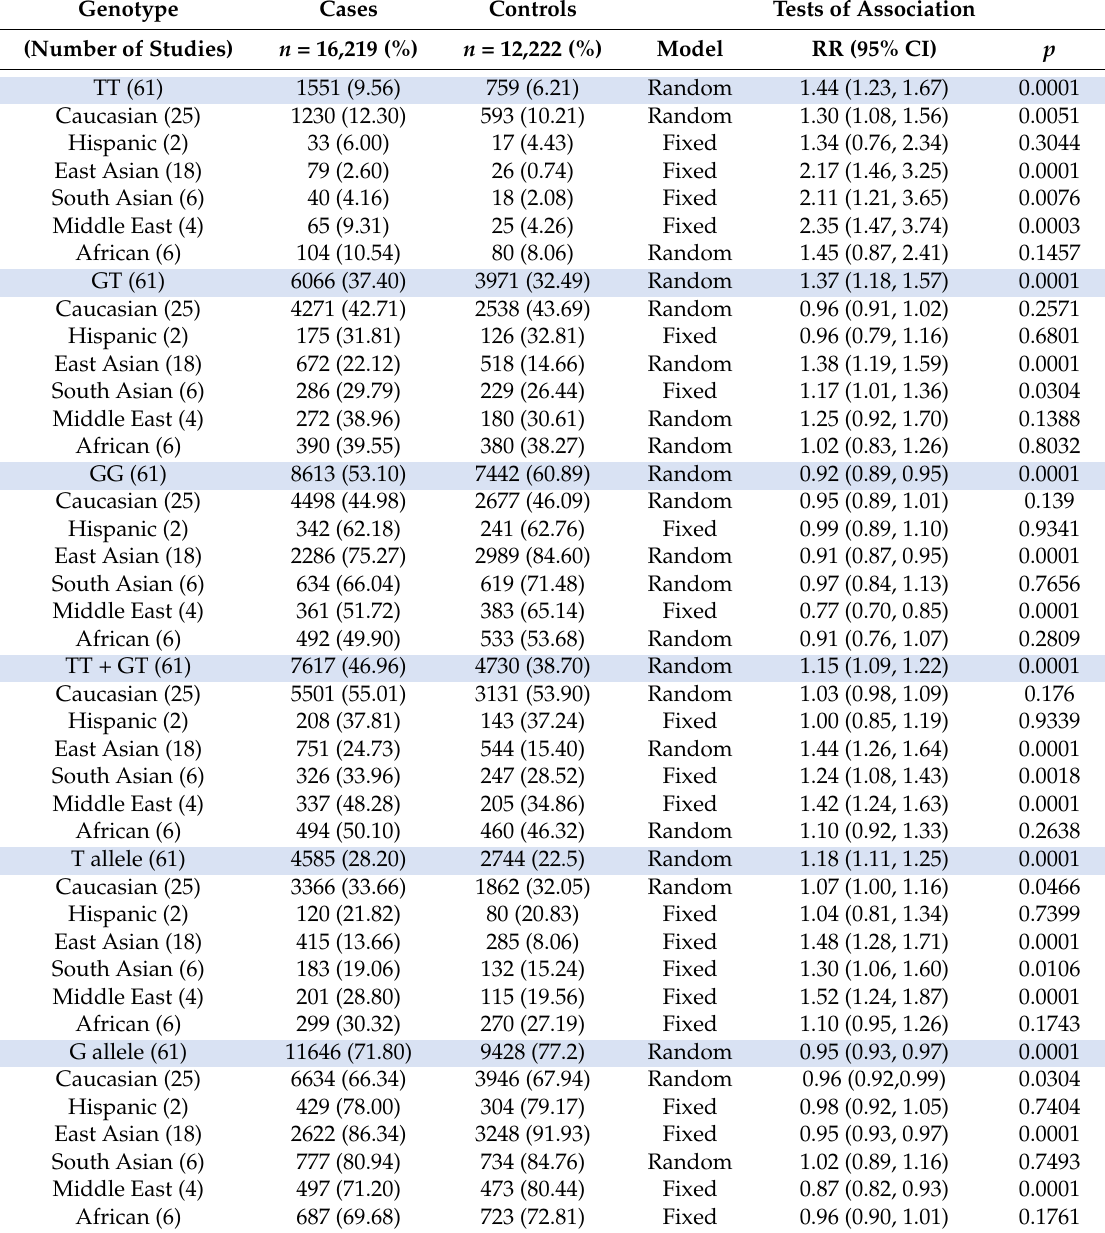
Table 1. Pooled meta-analysis: NOS3 G894T genotypes and risk for ischemic heart disease